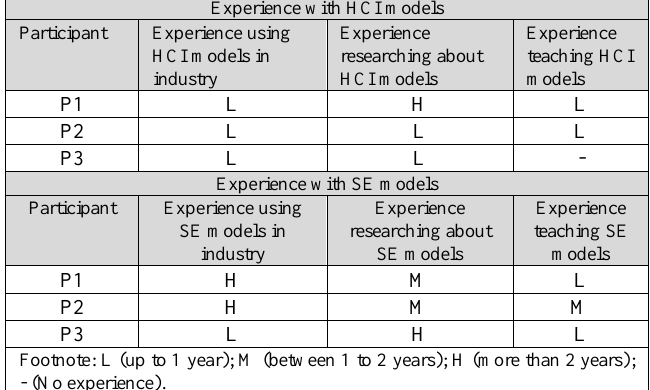
TABLE V. C HARACTERIZATION OF THE P ARTICIPANTS